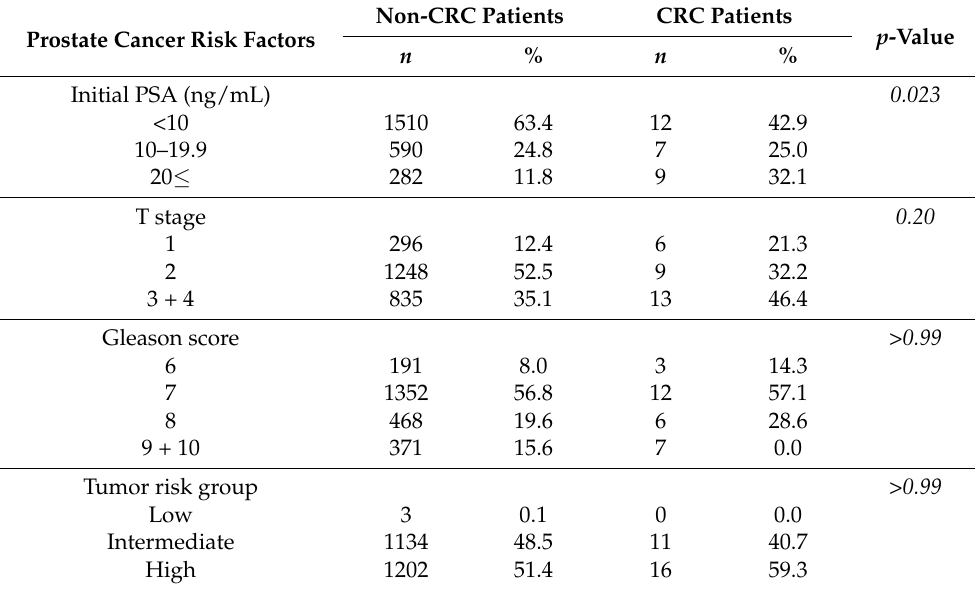
Figure 1. Flow diagram showing patient enrollment. GHMC, Gunma University Heavy Ion Medical Center; IBD, inflammatory bowel disease; CRC, colorectal cancer. Table 2. Association between CRC morbidity and clinical risk factors for PCa. Table 2. Association between CRC morbidity and clinical risk factors for PCa. Prostate Cancer Risk Factors